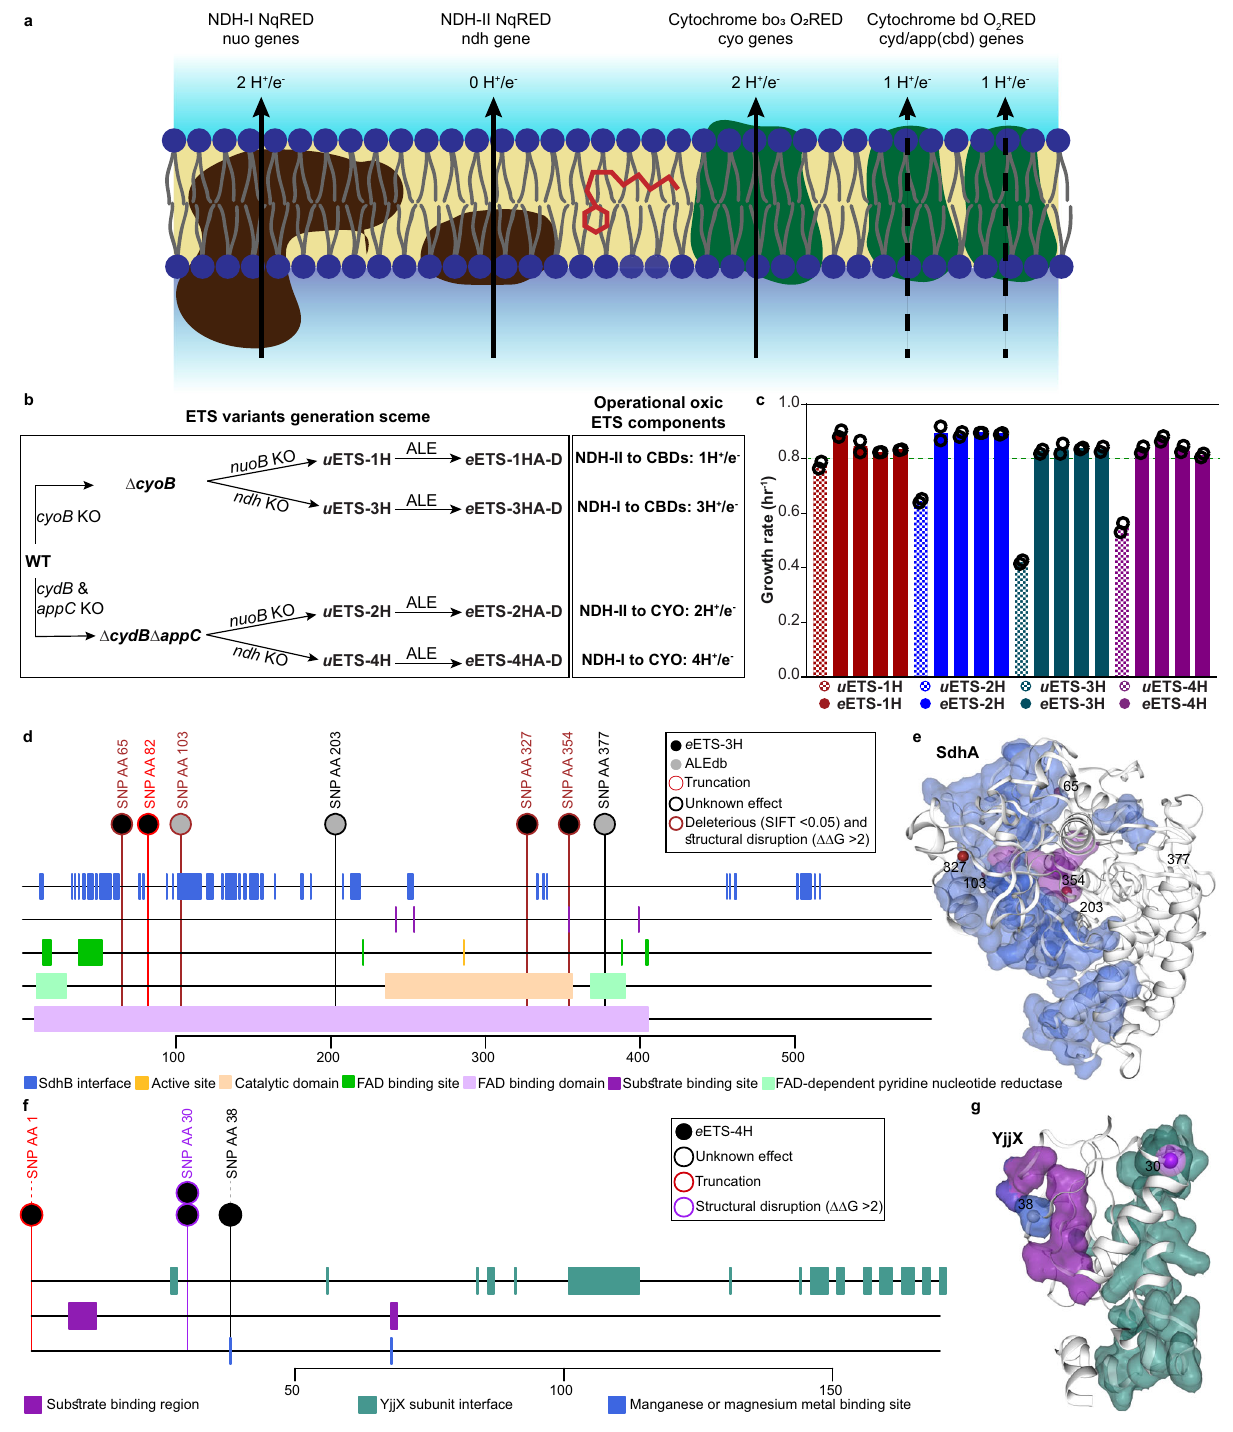
Fig. 1 Generation and evolution of unbranched ETS variants. a Schematic showing the respiratory enzymes involved in the fl ow of electrons from NADH (donor) to oxygen (acceptor). NDH-I and NDH-II are the proton pumping and non-pumping NADH: quinone oxidoreductase, respectively. Dashed arrows for CBDs represent the vectorial mode of PMF generation. b Scheme for generating ETS variants translocating 1, 2, 3, or 4 proton(s) per electron. u ETS is the unevolved strain and e ETS is the evolved strain. A – D are the four independently evolved lineages of each strain. c Growth rates of ETS variants before and after ALE. d , f Predictive mechanistic interpretation of the impact of mutations observed in the evolved strains of ( d ) ETS-3H ( sdhA ) and ( f ) ETS-4H ( yjjX ) mutations on the structure and function of the protein. Mutations displayed are those from this study and other ALE experiments in ALEdb seen to mutate these genes 10 . Horizontal tracks display the reported features associated with the region of the protein. The mutations collected from ALEdb refer to experiments from the following set, respectively 12,49,50 . Protein structures showing the amino acid residues mutated in ( e ) SdhA and ( g ) YjjX. Source Data available in Supplementary Table